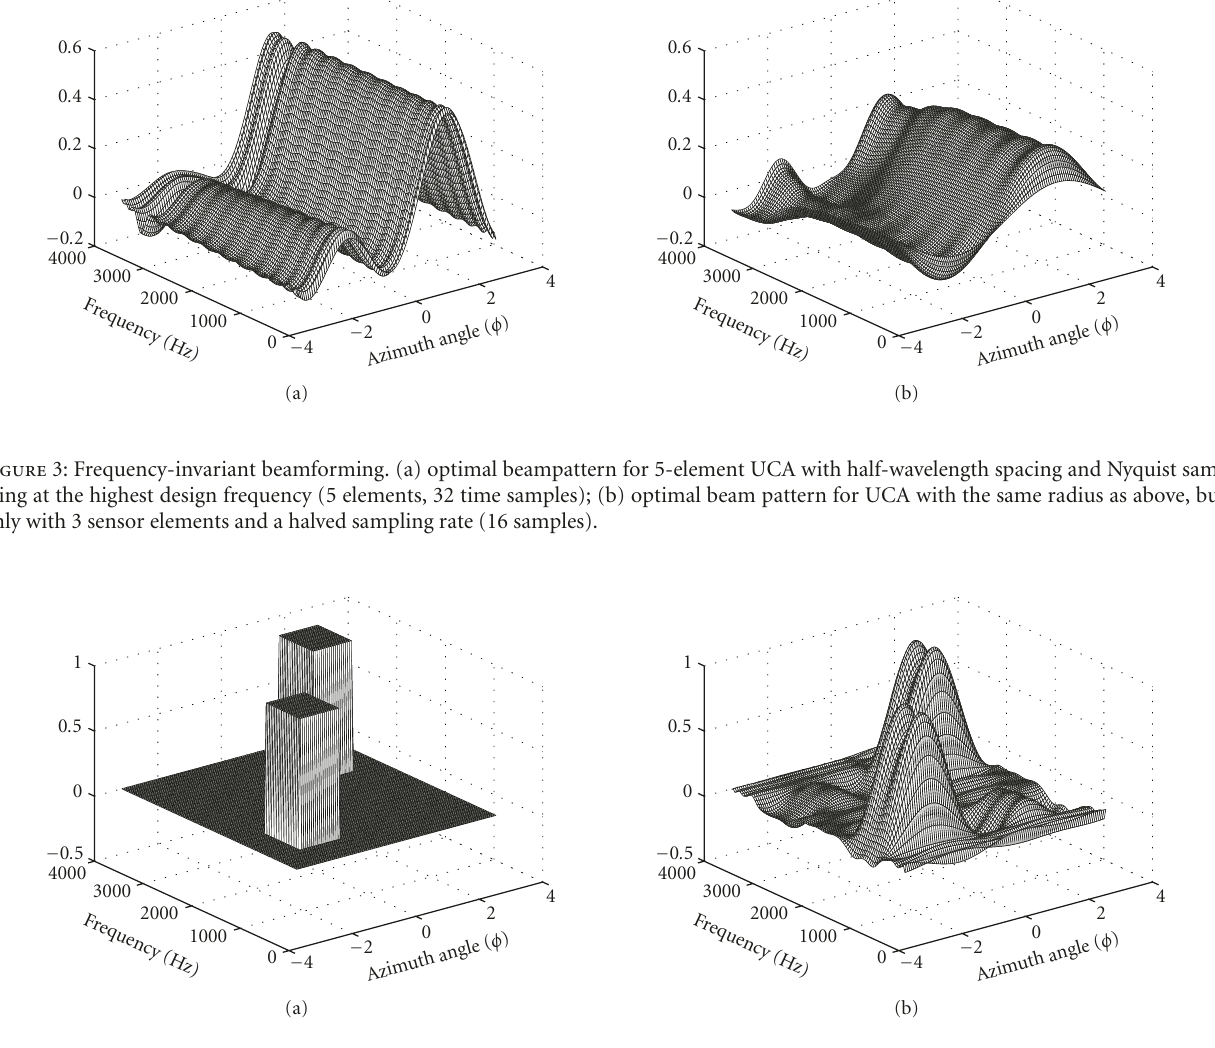
Figure 4: Spot beamforming: (a) desired pattern, W des ( k , φ ); (b) optimal achieved pattern, W ach ( k , φ ).